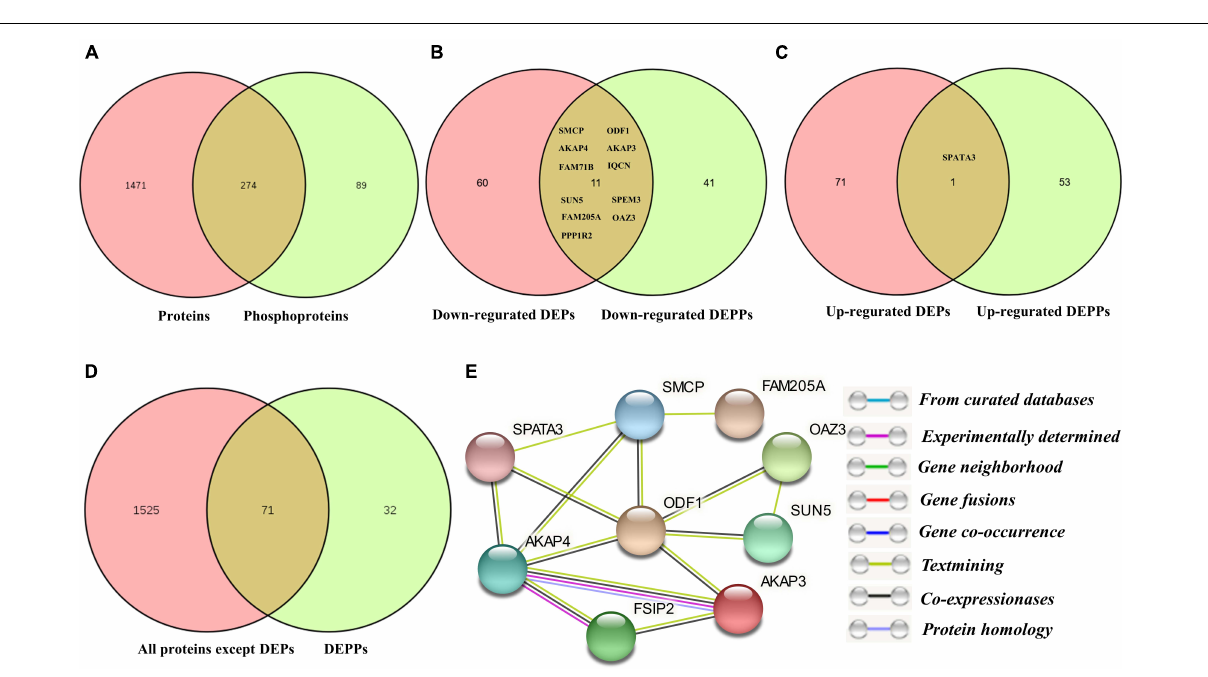
FIGURE 5 | The correlation analysis between DEPs and DEPPs. (A) Venn diagram of the correlation numbers between quantified proteins and phosphoproteins. (B) Venn diagram of the correlation numbers between downregulated DEPs and downregulated DEPPs. (C) Venn diagram of the correlation numbers between upregulated DEPs and upregulated DEPPs. (D) Venn diagram of the intersection numbers between total identified porcine boar sperm proteins and DEPPs. (E) The protein–protein interaction network of the 14 overlapped proteins between DEPs and